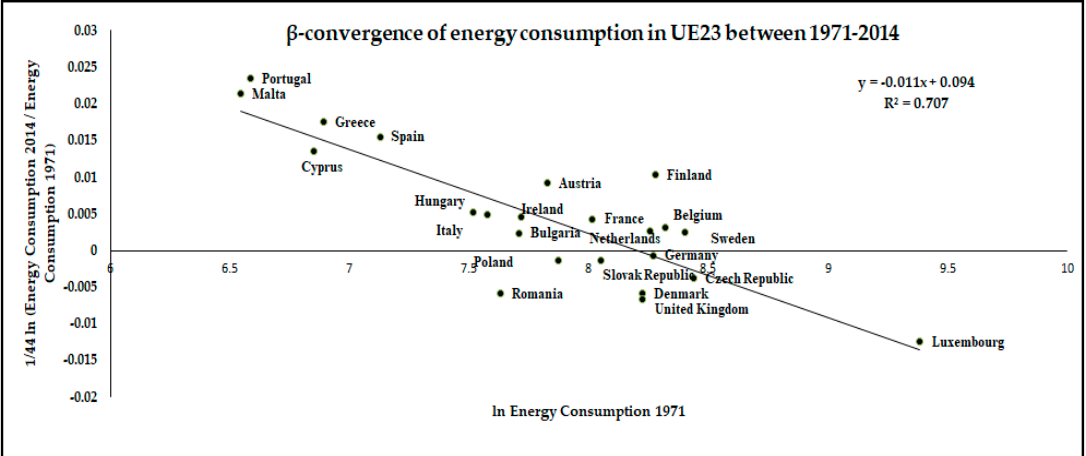
Figure 3. β -convergence of energy consumption in UE23 1971–2014 (Model 3).